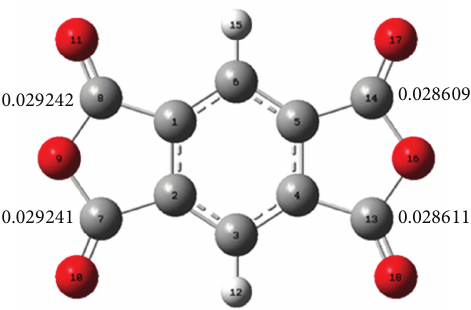
Figure 6: The Fukui function calculated for atoms involved in the ring-opening of dianhydride 2